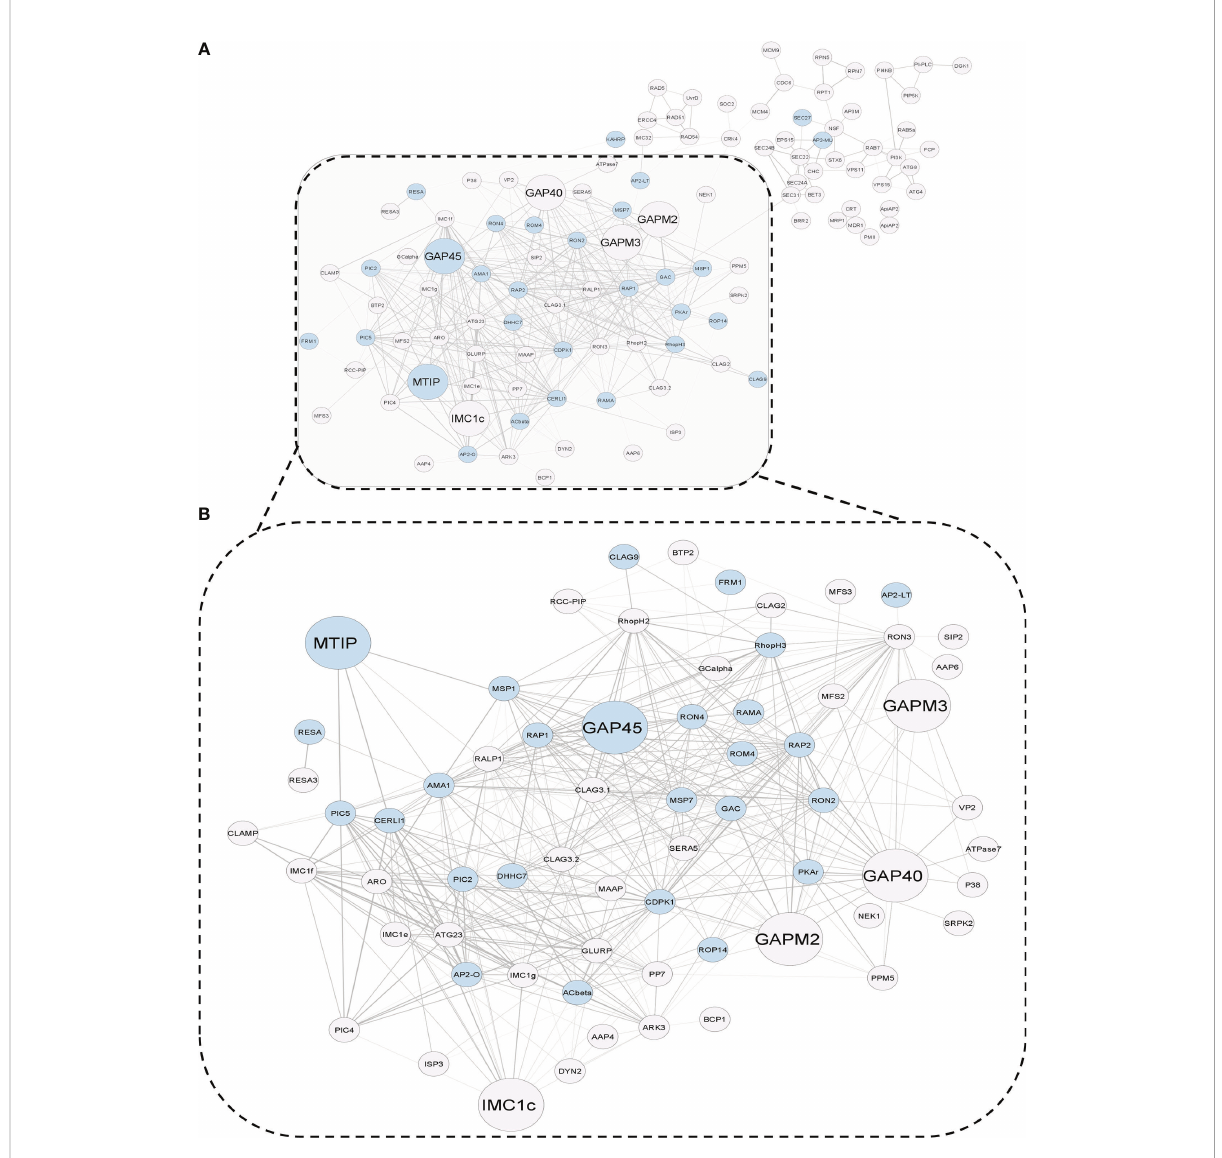
FIGURE 3 (A) STRING-generated Protein – Protein Interaction graph of dually modi fi able proteins in k-means cluster 4. The PPI map draws a relationship between the molecular factors of parasitic invasion (blue nodes) and glideosome-mediated motility (larger nodes) in P. falciparum 3D7, which are processed by a crosstalk of Palmitoylation and Phosphorylation . (B) A functional subnetwork of major glideosome and invasion motor complex-related proteins, which has been termed as the infection-associated Motility and Invasion Complex (MIC) (dotted